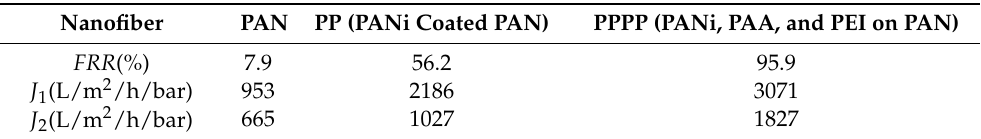
Table 1. The flow recovery rate ( FRR ) and flux ( J ) tested using n-hexane/water emulsion. Adapted and modified with permission from [52], ©2021 Elsevier B.V. Nanofiber PAN PP (PANi Coated PAN) PPPP (PANi, PAA, and PEI on PAN) FRR (%) 7.9 56.2 95.9